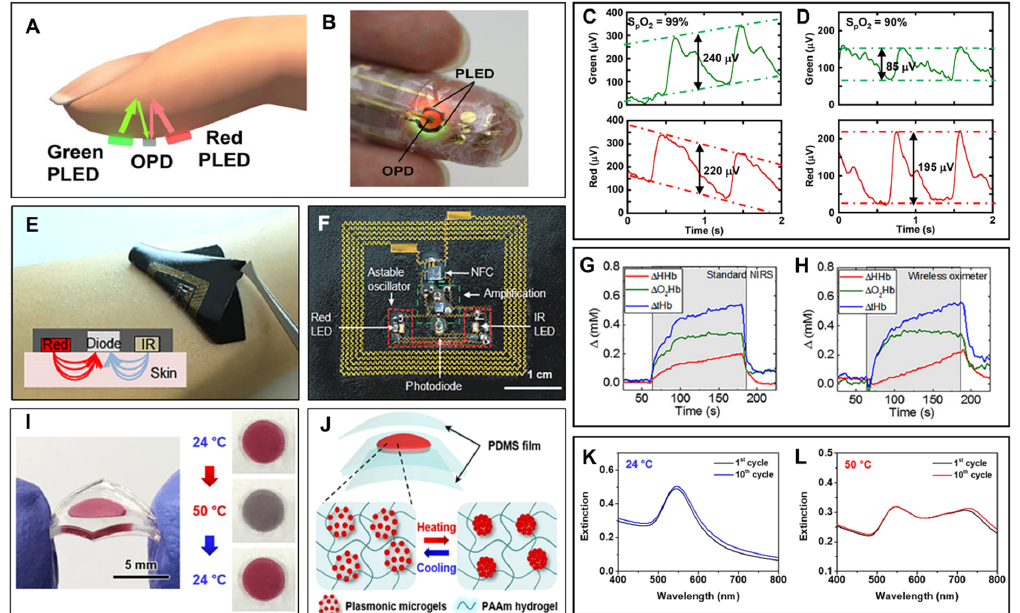
Figure 4. Wearables using optical transducers. ( A ) Schematic illustration of the reflective pulse oxime- try from finger [147]. OPD records the reflected light intensity that is illuminated synchronously by the green and red PLEDs to extract the PPG and the resulting SpO 2 . ( B ) Photograph of Yokota et al.’s ultra-flexible polymer oximeter wrapped on the finger [147]. ( C ) Demonstrated SpO 2 extraction at green and red wavelengths by the change of the PPG signal intensity [147]. ( D ) A 9% change in the SpO 2 value (from 99% to 90%) yields a detectable intensity change in the resulting PPG signal at both wavelengths [147]. ( E ) Epidermal wireless pulse oximeter demonstrated by Kim et al.